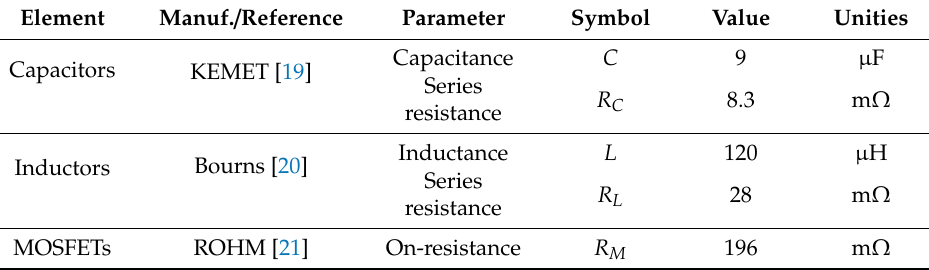
Table 3. Parameters of the power converter in